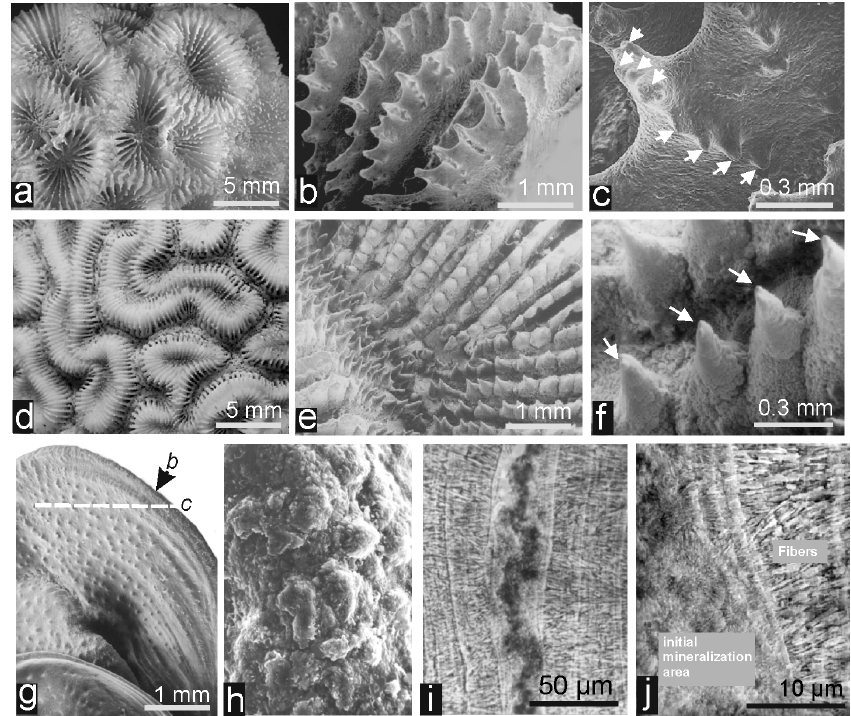
Figure 2. Taxonomy-linked skeletal patterns in the Scleractinia: ( a – c ) distal growth edge of Favia fragum ; and ( d – f ) Distal growth edge of Diploria labyrinthica. These species illustrate the specific and easily recognizable morphologies of the distal growth edges, each of them corresponding to a specific distribution of the two distinct mineralizing areas. ( g , j ) Organization of calcareous components in the septum of the DSSC Lophelia sp. The linear septum of the Lophelia corallites (see Figure 1a,b) is built by two microstructurally distinct areas: the distal growth edge ( h ); and symmetrically deposited onto lateral sides the layers of fibrous tissue ( i ). Interestingly, these two microstructurally distinct aragonitic compartments ( j ) exhibit specific and strongly distinct chemical, biochemical and isotopic properties [8,15,29], although synchronically deposited by the basal ectoderm layer of the polyp.